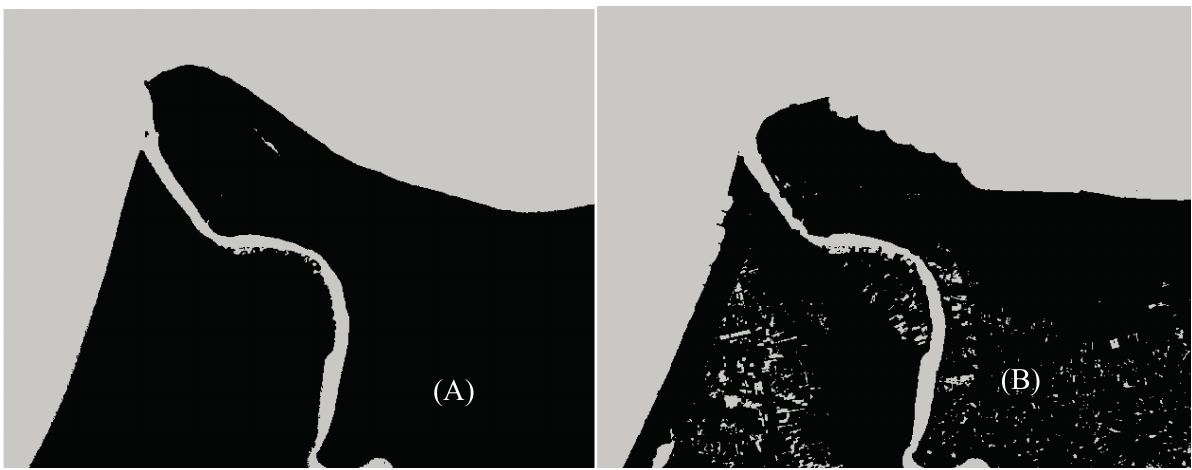
Figure 6. Shoreline changes in Rosetta Promontory between 1984 and 2014.